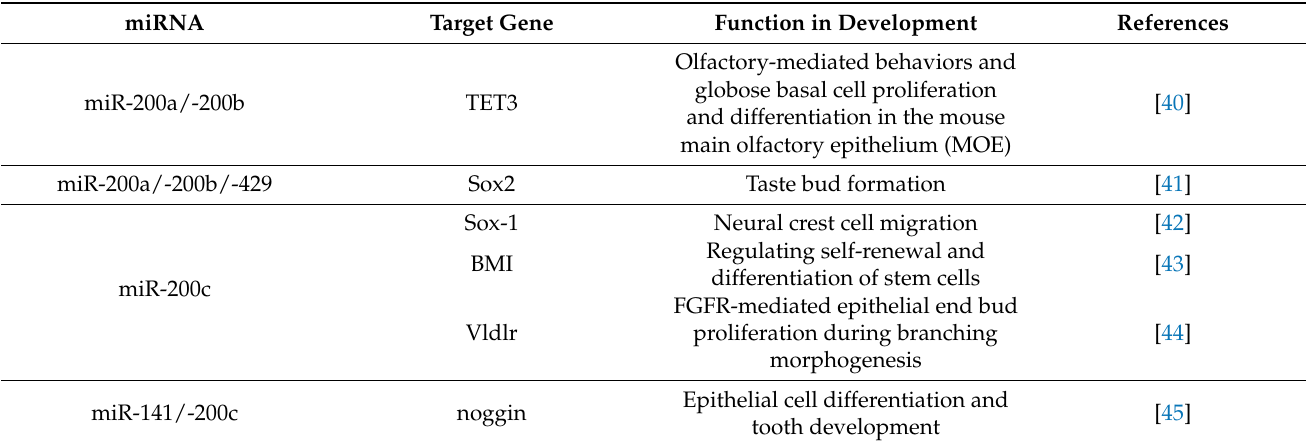
Table 1. miR-200s, target genes, and their roles in